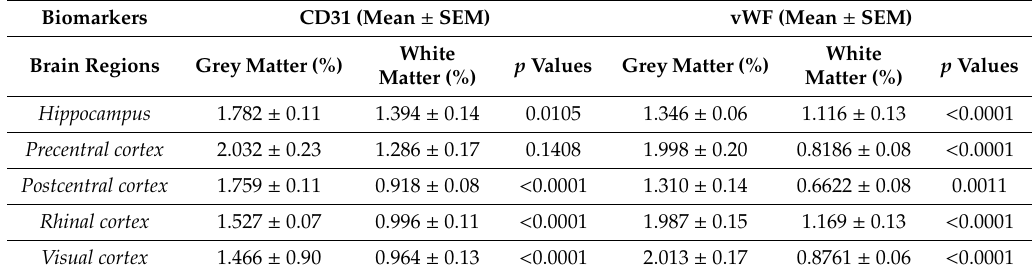
Table 1. Percentage area of expression of CD31 vWF by endothelial cells in five di ff erent brain regions. The two markers varied in their expression as quantified. The expression of CD31 was highest in the precentral cortex and vWF expression was highest in the visual cortex. Expression of both markers was higher in the grey matter than in the white matter with statistically significant di ff erences, except for the precentral central cortex for the expression of CD31. (n = 15, three patients, five regions of